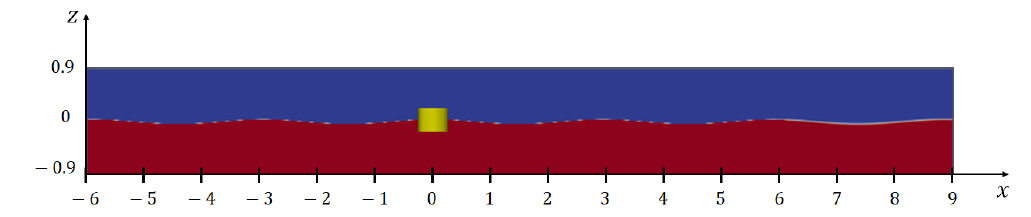
Figure 13. Initial buoy position and free surface for a moored buoy in wave.